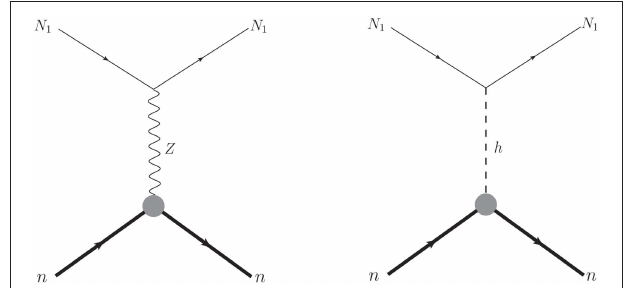
FIGURE 23 | Feynman diagrams of SI direct detection of singlet-doublet N 1 DM.